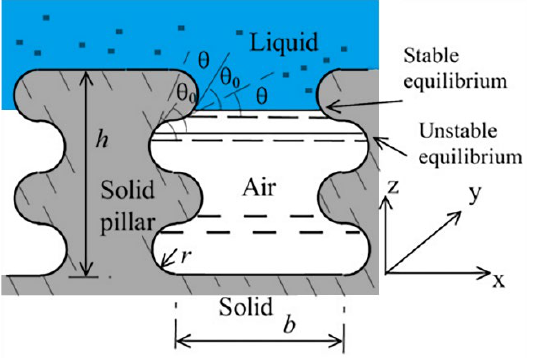
Figure 6. Schematic illustration for the variations in normalized free energy with apparent contact angle for C–B, C–B metastable, and W states on multi-scaled microstructure. Reprinted with permission from Ref. [102]. Copyright@2017, Physicochemical and Engineering.